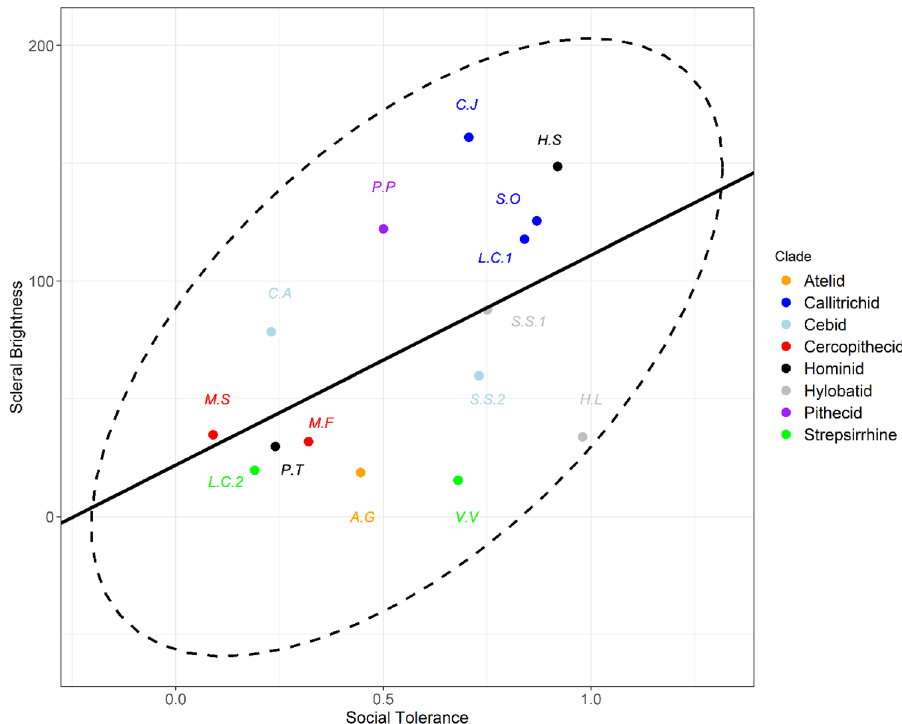
Figure 3. Social tolerance and scleral brightness. PGLS regression plot comparing social tolerance scores with scleral brightness in 15 primate species. Ellipse showing bivariate outliers to a 95% confidence interval. CJ Callithrix jacchus, HS Homo sapiens, SO Saguinus oedipus, LC1 Leontopithecus chrysomelas, PP Pithecia pithecia, SS1 Symphalangus syndactylus, SS2 Saimiri sciureus, CA Cebus apella, MS Macaca silenus, MF Macaca fuscata, HL Hylobates lar, PT Pan troglodytes, LC2 Lemur catta, AG Ateles geoffroyi, VV Varecia